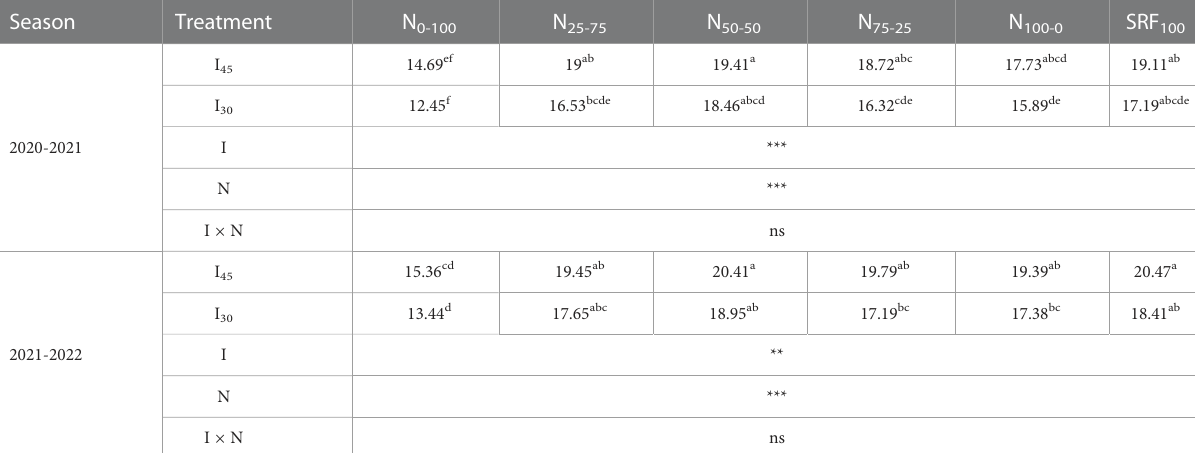
TABLE 5 In fl uence of different irrigation scheduling and nitrogen application modes on winter wheat aboveground biomass (t ha − 1 ) during 2020- 2021 and 2021-2022 growing seasons. Season